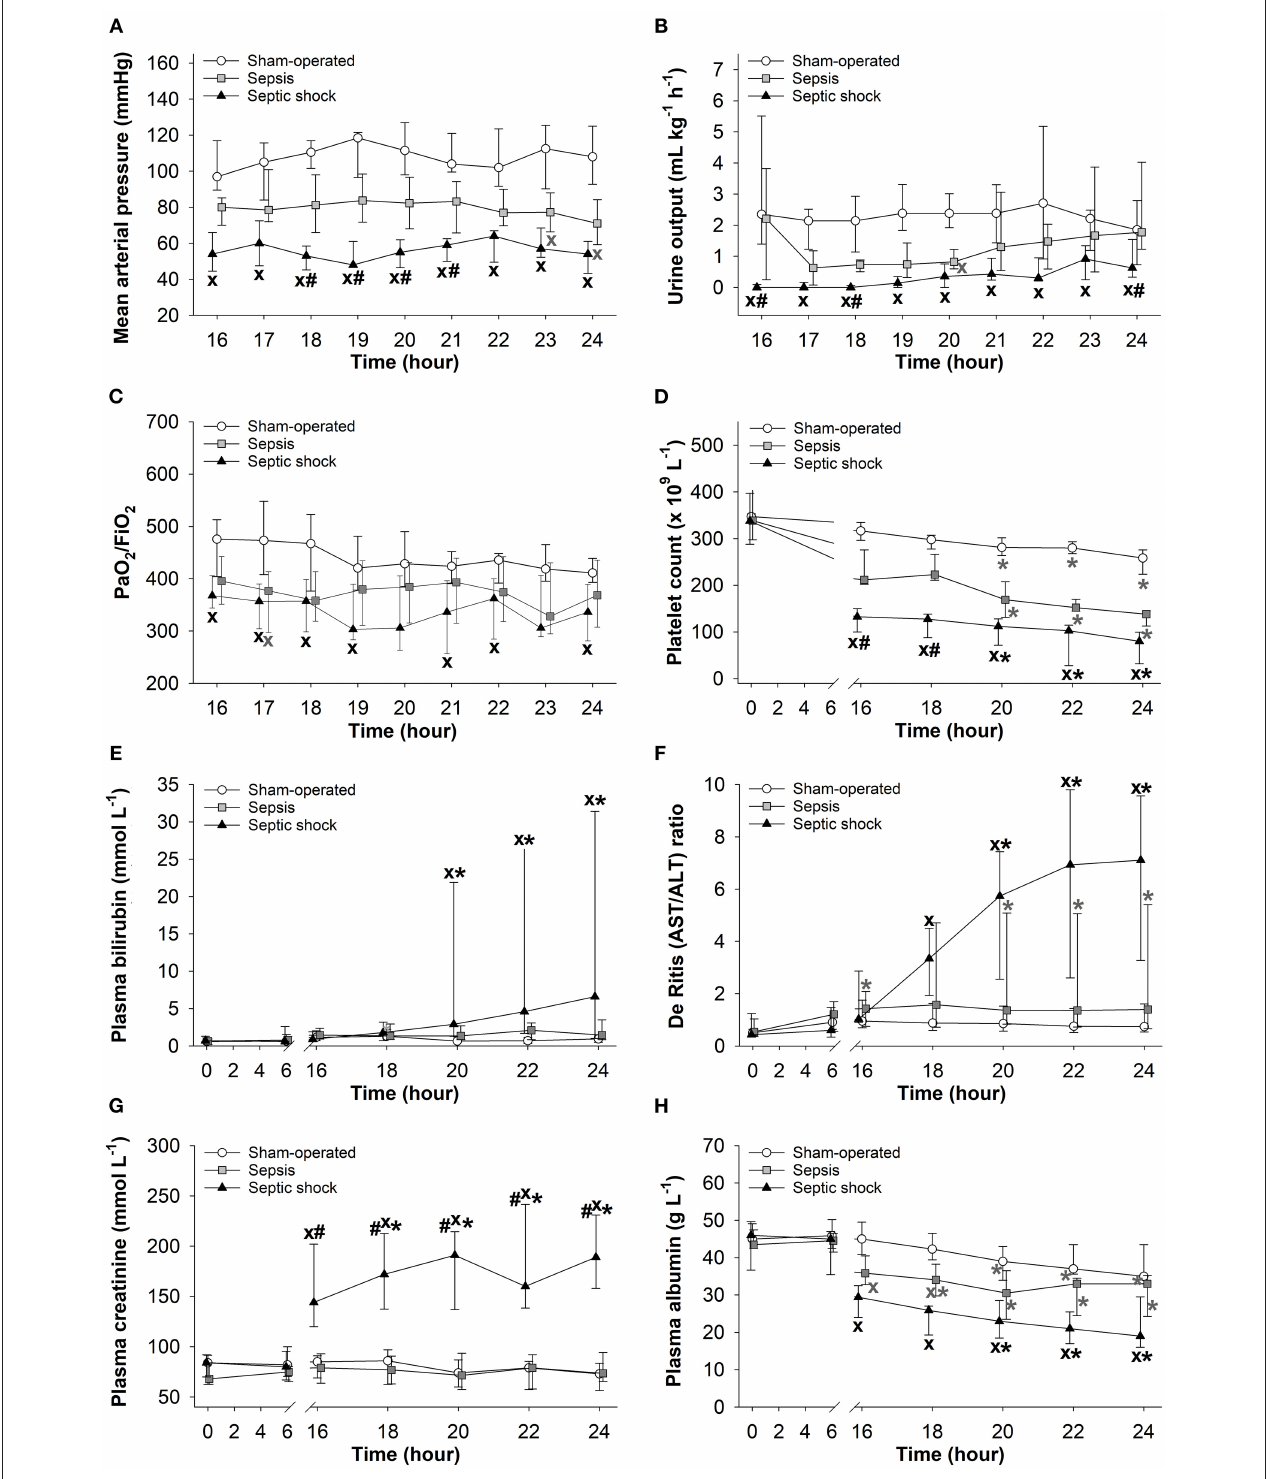
FIGURE 3 | Changes in mean arterial pressure (A) , urine output (B) , PaO 2 /FiO 2 ratio (C) , platelet count (D) , plasma bilirubin (E) , De Ritis (AST/ALT) ratio (F) , plasma creatinine (G) , and plasma albumin levels (H) in the sham-operated group (open circles) and the sepsis (gray square) and septic shock subgroups (black triangle). The plots demonstrate the median values and the 25th (lower whisker) and 75th (upper whisker) percentiles. X P < 0.05 vs. sham-operated group; # P < 0.05 vs. sepsis group; (A–D) * P < 0.05 vs. t = 16h; (E–H) * P < 0.05 vs. t = 0h.